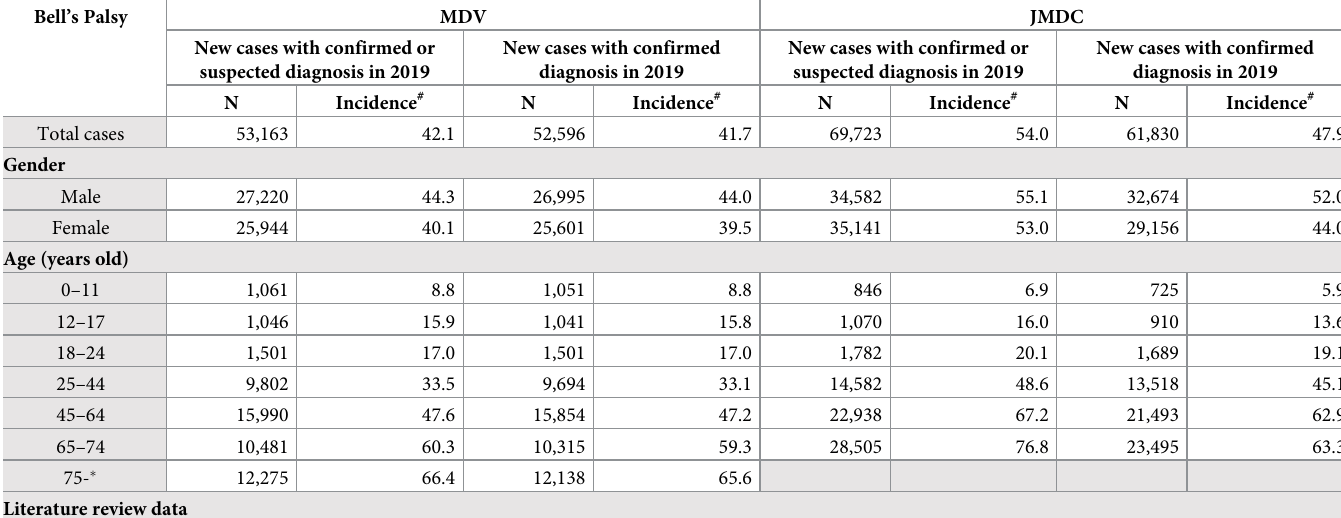
Table 3. Estimated incidence of Bell’s